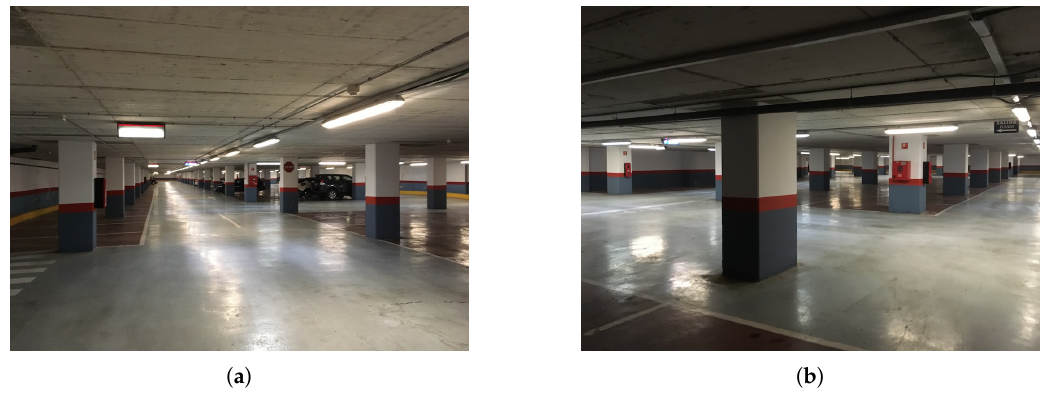
Figure 5. Location for the localisation experiments, the underground car parks of the UPV. ( a ) north-south orientation; ( b ) east-west orientation.